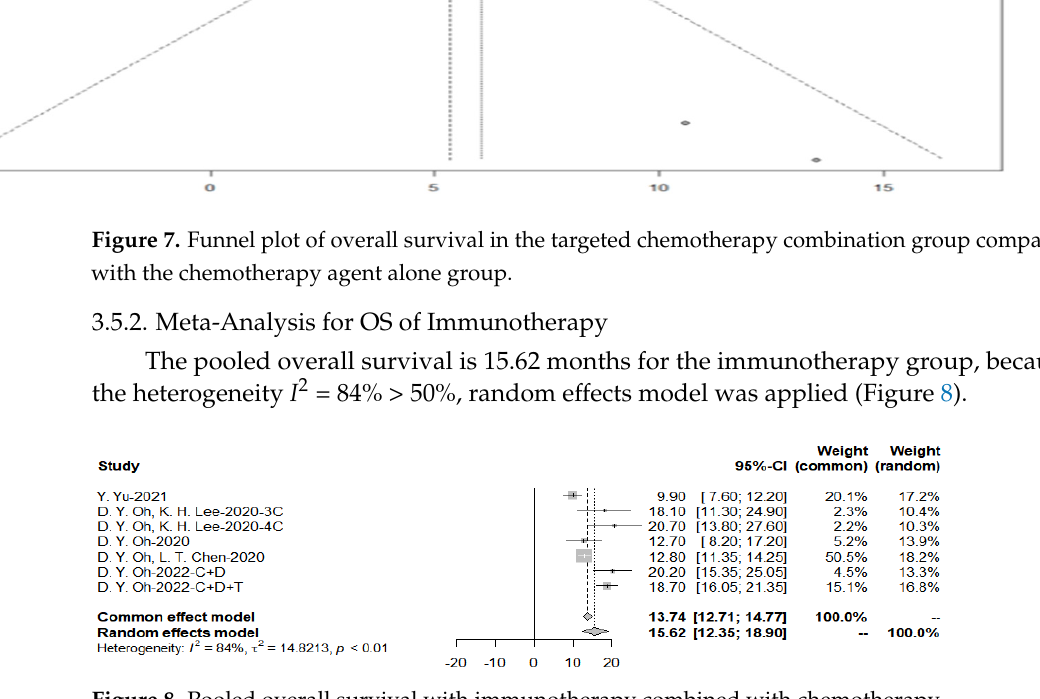
Figure 7. Funnel plot of overall survival in the targeted chemotherapy combination group compared with the chemotherapy agent alone group.